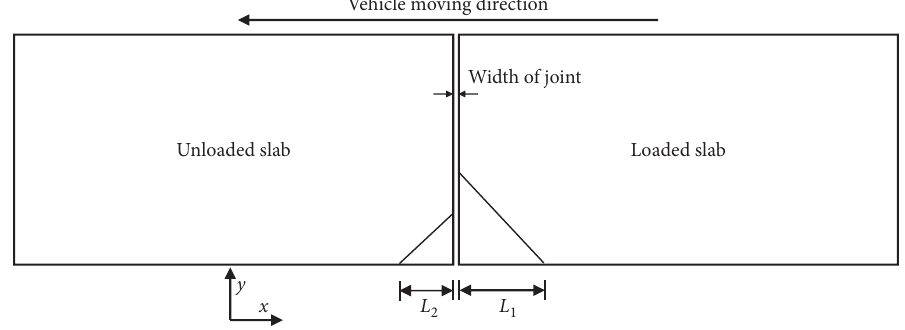
Figure 3: Void morphology of the FEA model.